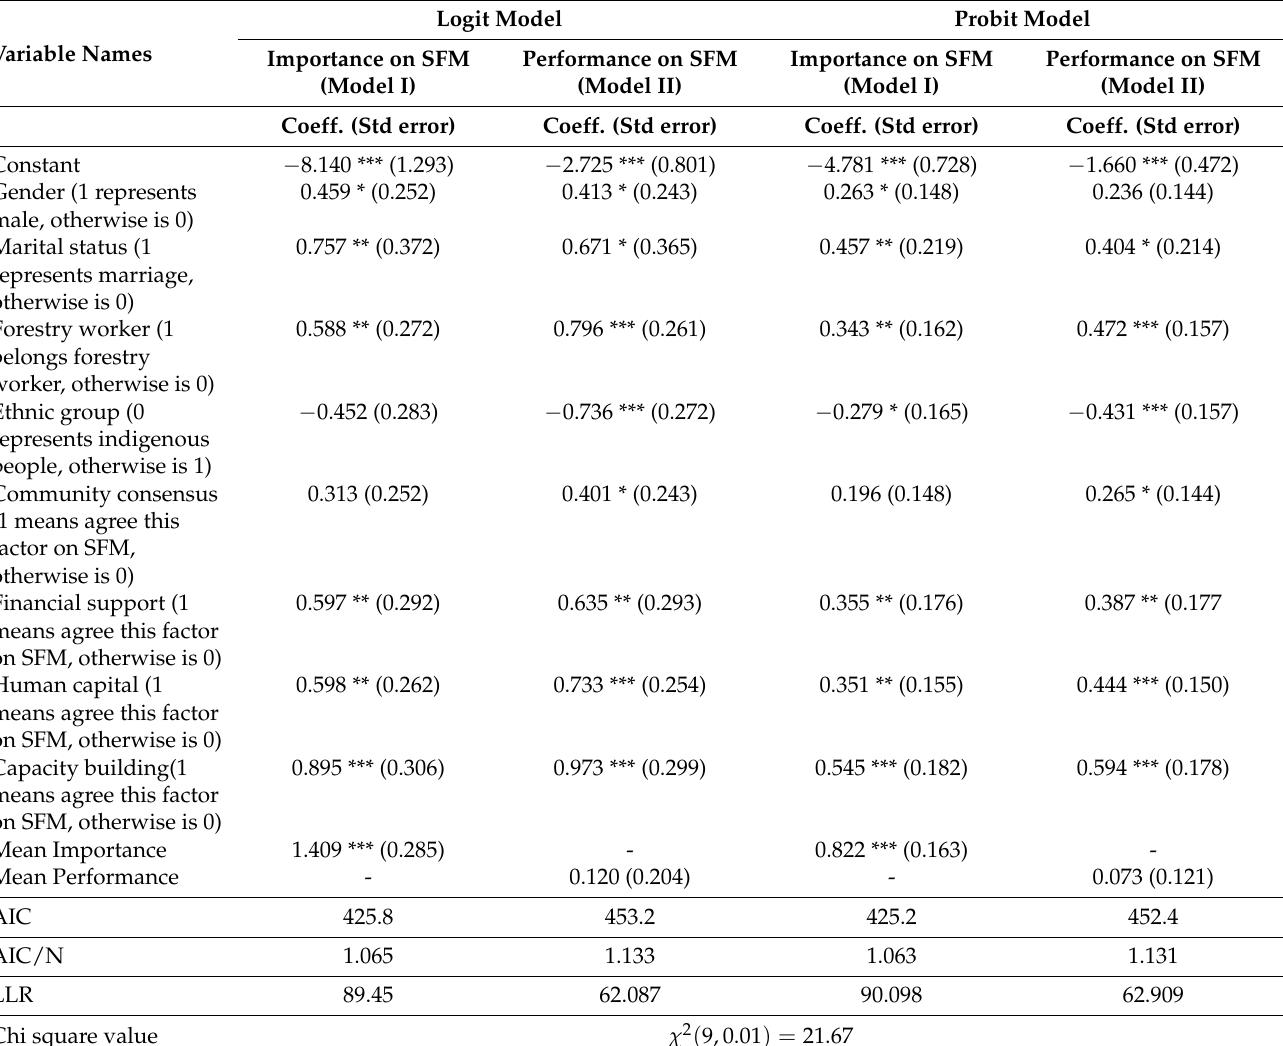
Table 4. Estimation results of local people’s perception for SFM participation